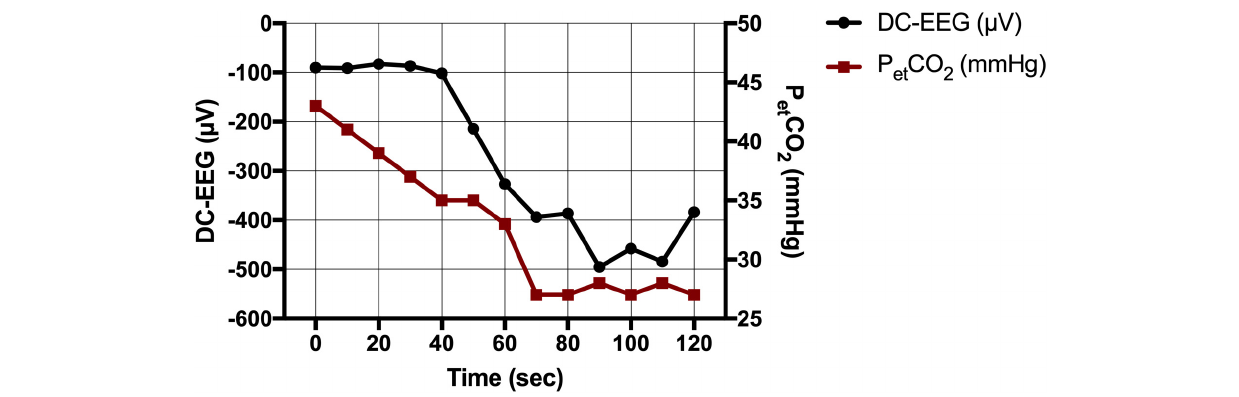
decrease of 1 mmHg p et CO 2 was 39.5 (23.0; 65.1) µ